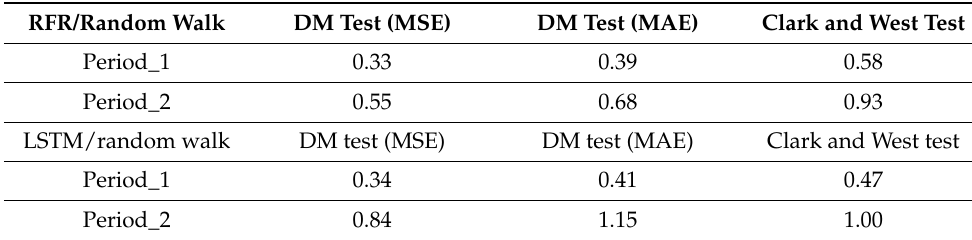
Table 11. D–M test and C–W test results on the significant difference between random walk and random forest regression or